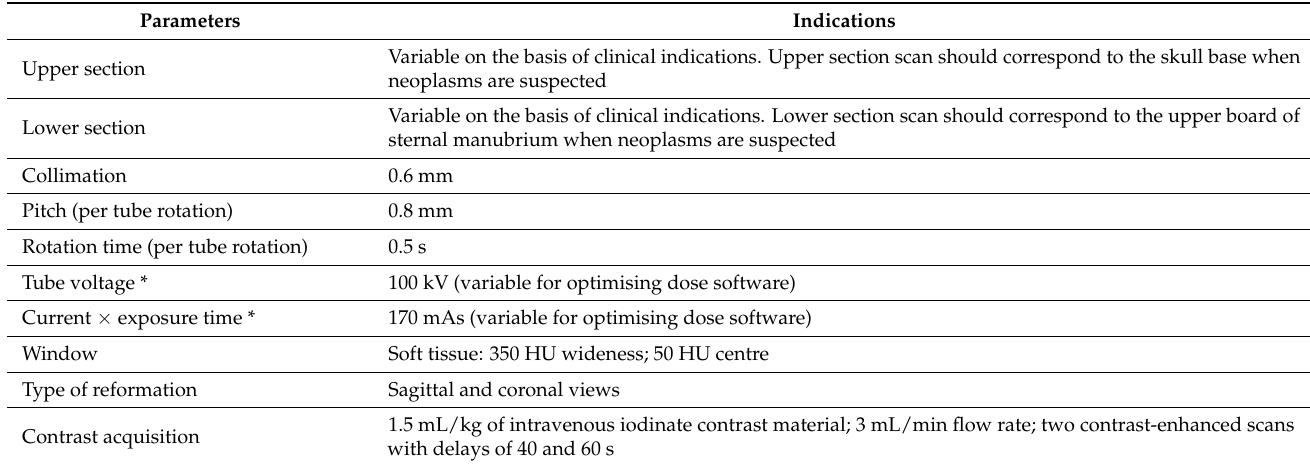
Table 2. Parameters for oral cavity standard acquisitions performed with SOMATOM Definition AS 128 Slice CT Scan (Siemens Healthcare, Erlangen,